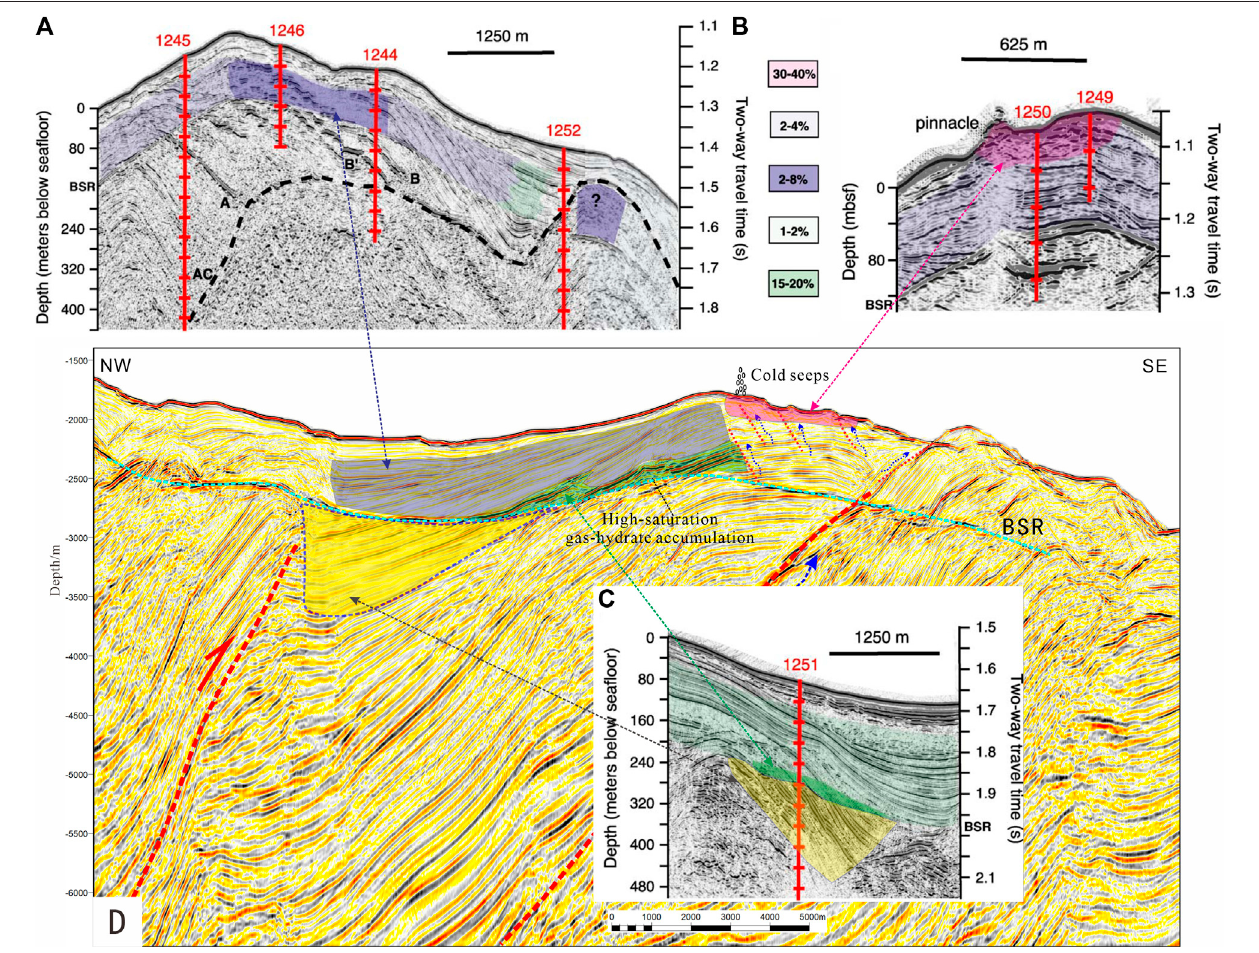
FIGURE 9 | Compared with ODP204 drilling results to speculate the gas hydrate saturation of Makran Accretionary Prism (modi fi ed after Tréhu et al., 2004). (A) seismicpro fi leacrossthesite1245,1246,1244and1252ofODP204. (B) seismicpro fi leacrossthesite1250,1249ofODP204. (C) seismicpro fi leacrossthesite1251 of ODP204. The transparent color areas of pro fi le A, B, C represent different gas hydrate saturation calculated from the ODP204 drilling results. (D) seismic pro fi le and inferred different concentration zones of gas hydrate in Makran Accretionary Prism.